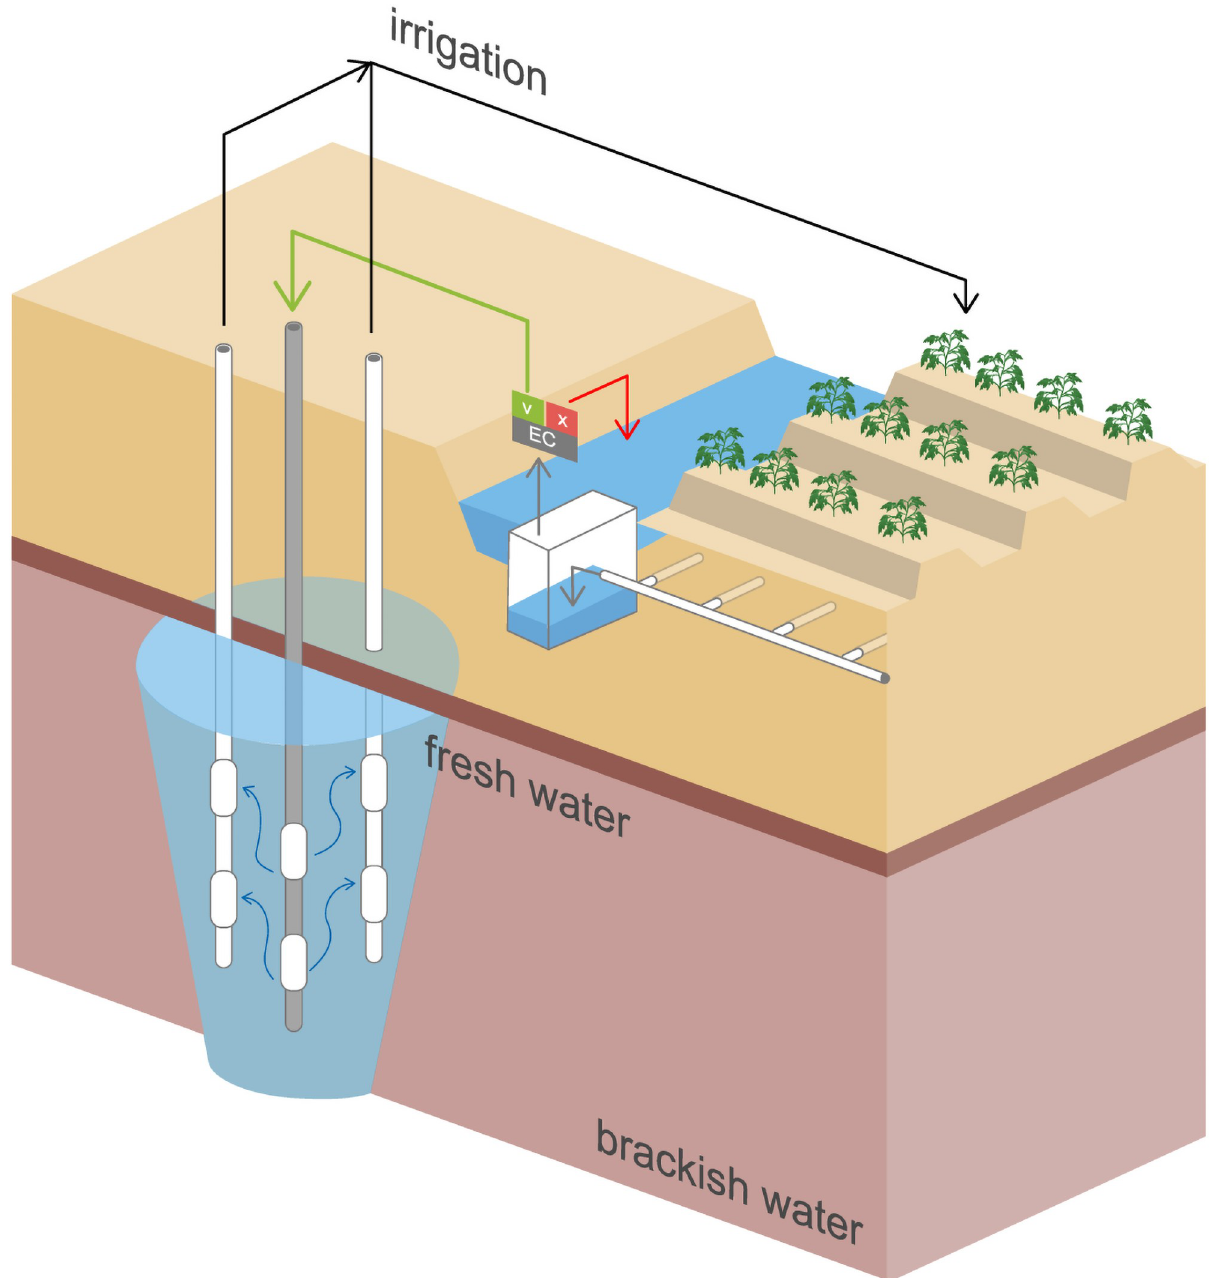
Fig 1. Scheme of a managed aquifer site. Schematic representation of an agricultural field connected to a managed aquifer recharge site. The site is designed as an aquifer, storage, transfer, and recovery (ASTR) system. Excess rain water reaches the tile drainage system buried at 70 cm depth. The collection drain terminates into a concrete reservoir where the EC of the tile drainage water is measured. If the EC is below a set threshold value, the water is infiltrated via the injection well (depicted in gray). From there, the water travels through the sandy aquifer to the extraction wells (depicted in white) and can be used for